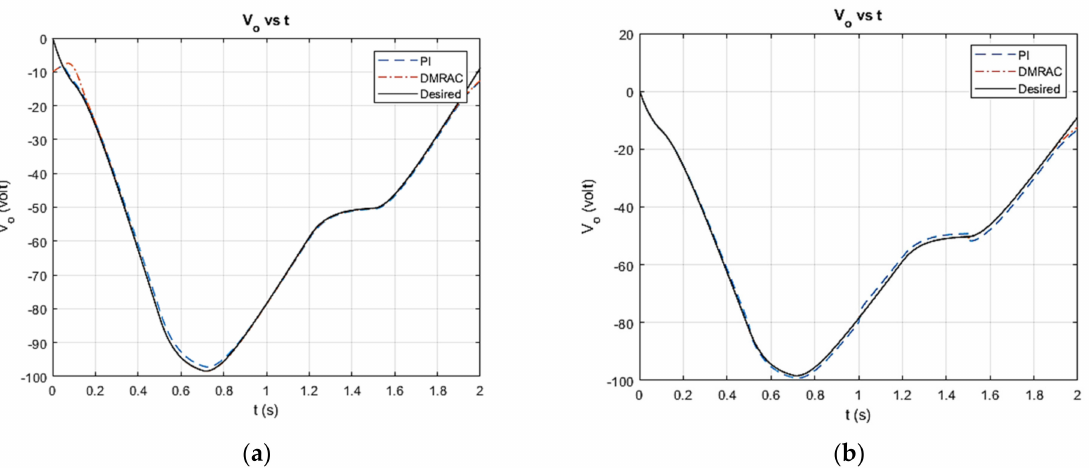
Figure 6. Variable voltage tracking ( a ) without the presence of disturbance in the system and ( b ) in presence of disturbance in the